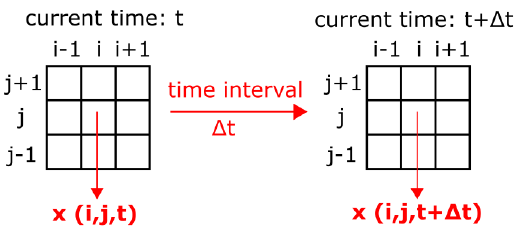
Figure 5. Representation of the central pixel and its neighboring pixels at the time points before and after the movement.